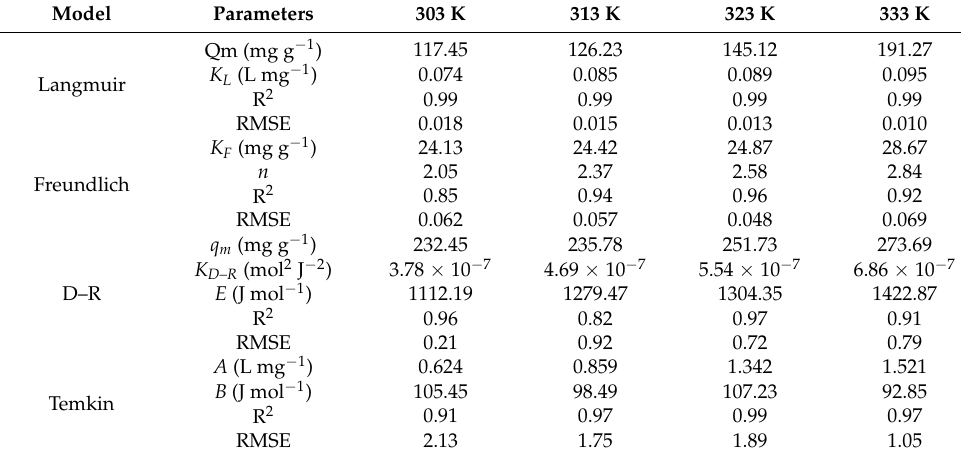
Figure 6. 2D interactive contour plot depicting variation of adsorption capacity with respect to ( a ) contact time vs. pH, ( b ) pH vs. Pb (II) concentration and ( c ) adsorbent dose vs. pH. Table 1. Adsorption isotherm data obtained through the linear regression method for removal of Pb (II) onto XGFO